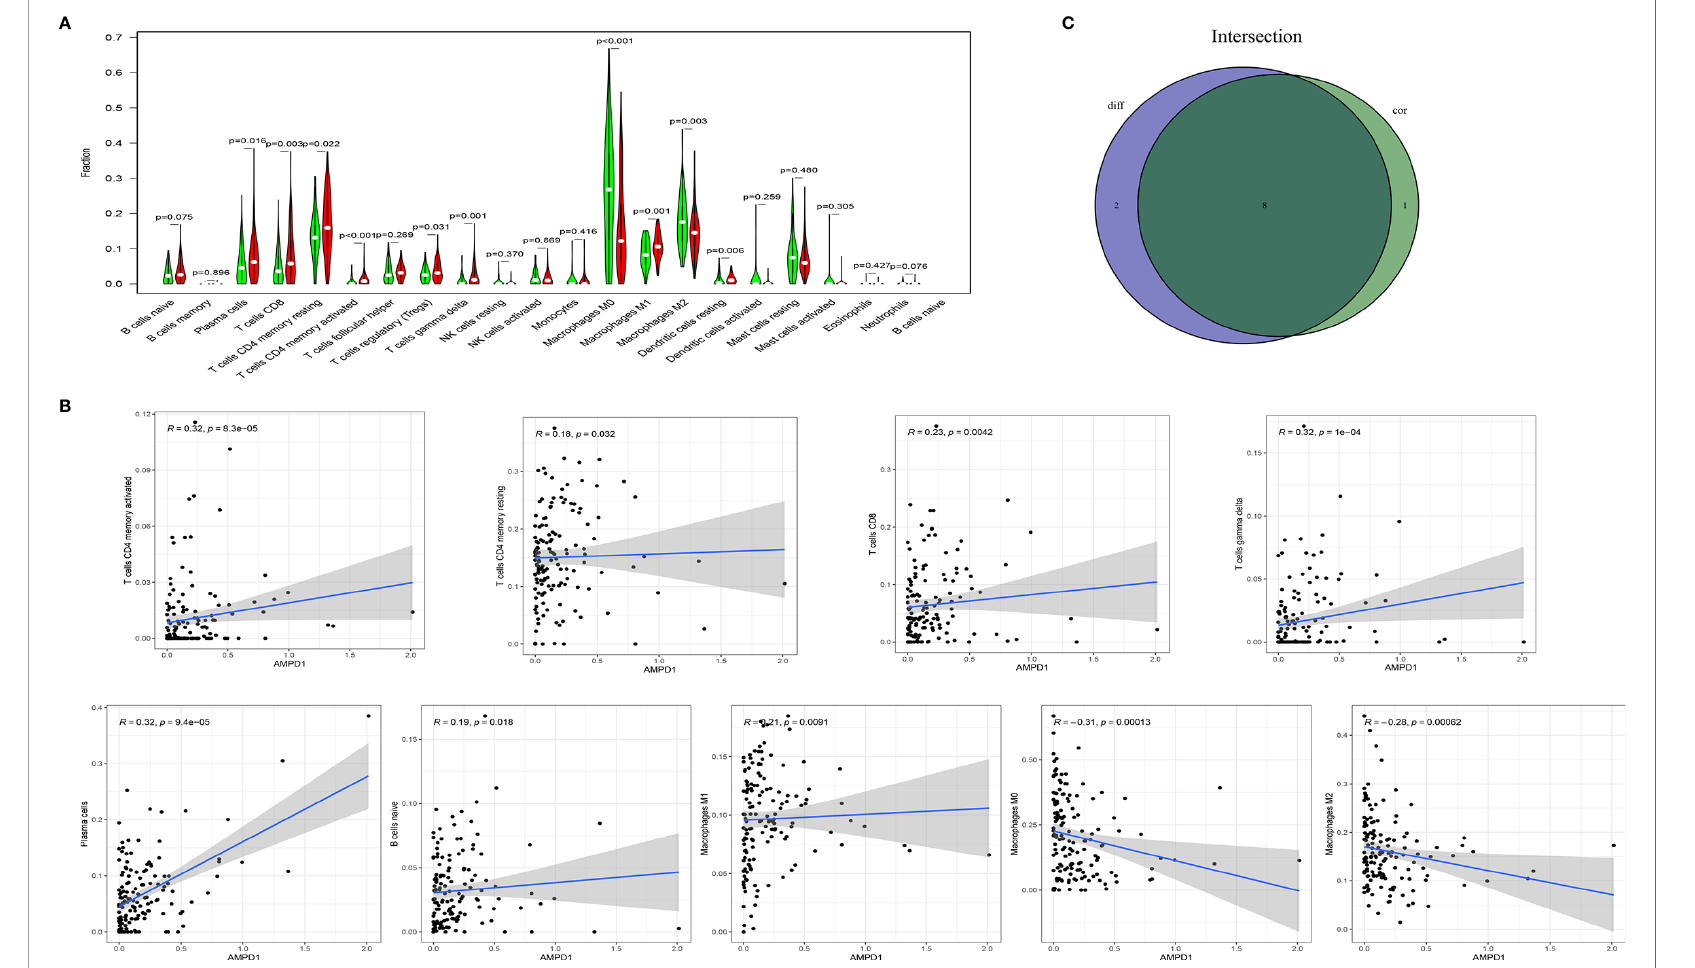
FIGURE 7 | Differences in proportions of TICs between high and low AMPD1 expression groups and correlations of TICs with AMPD1 expression. (A) Violin plots of the proportions of 21 immune cell types in tumor tissues with low (green) or high (red) AMPD1 expression, compared using the Wilcoxon rank sum test. (B) Scatter plots showing Pearson correlation between the proportions of the 9 TICs and AMPD1 expression. Blue lines denote the best- fi t linear models. (C) Venn diagram of intersection between analyses in (A, B) showing that 8 TICs were shared between the